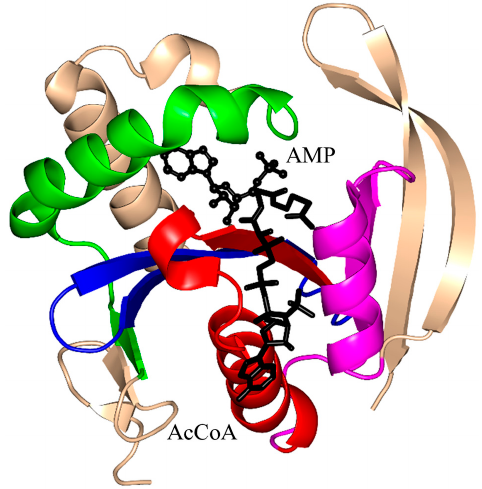
Figure 8. Cartoon representation of the structure of the acetyltransferase domain of E. coli MccE in complex with AcCoA and adenosine monophosphate (AMP) (PDB ID: 3R96 [104]). The conserved and non-conserved motifs of the GNAT domain, cofactor and substrate are colored as in Figure 3. 2.7. Pseudaminic Acid Biosynthesis Protein H Family (PseH, EC 2.3.1.202)